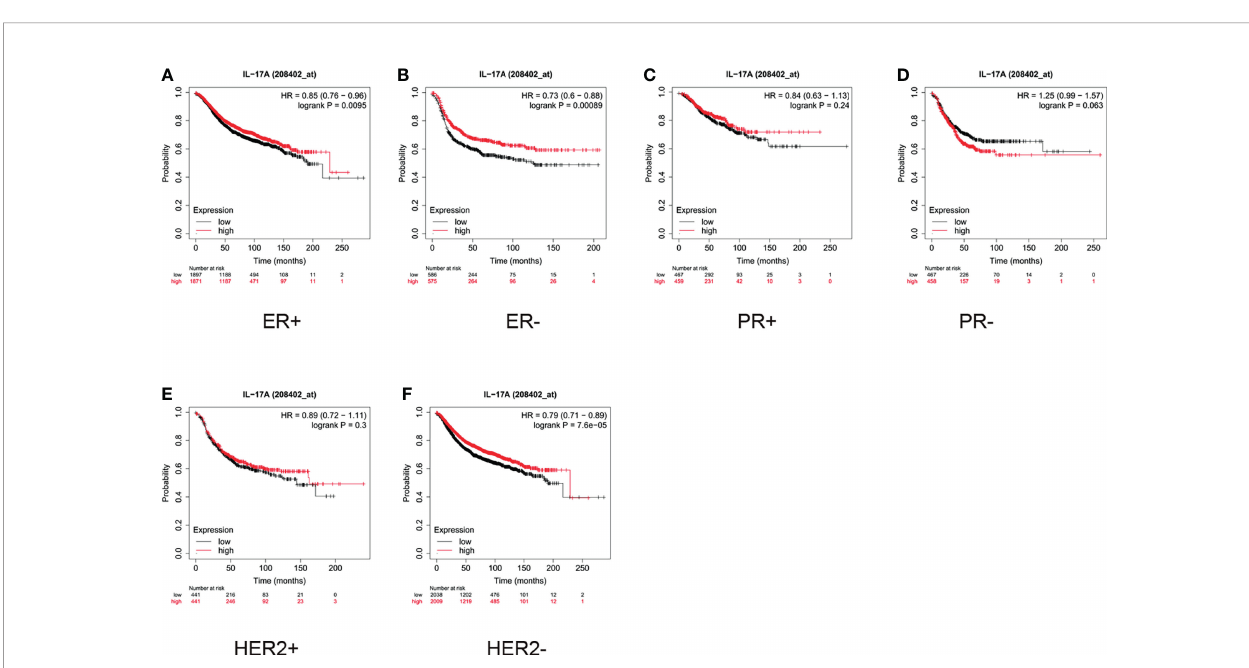
FIGURE 5 | In breast cancer patients, high expression of interleukin (IL)-17 only indicated better prognosis in estrogen receptor-positive (ER+), ER-negative (ER-), and human epidermal growth factor receptor 2 negative (HER2-) subgroups. High expression of IL-17 indicated better prognosis in (A) ER+ (hazard ratio [HR] = 0.85, p < 0.001) and (B) ER- (HR = 0.73, p < 0.001) patients. (C, D) IL-17 expression did not signi fi cantly in fl uence survival in progesterone-positive (PR+; HR = 0.84, p = 0.24) or PR- (HR = 1.25, p = 0.063) subgroups. (E) High expression of IL-17 did not correlate with better prognosis in HER2+ patients (HR = 0.89, p = 0.3). (F) High expression of IL-2 indicated better prognosis in HER2- patients (HR = 0.79, p < 0.001).